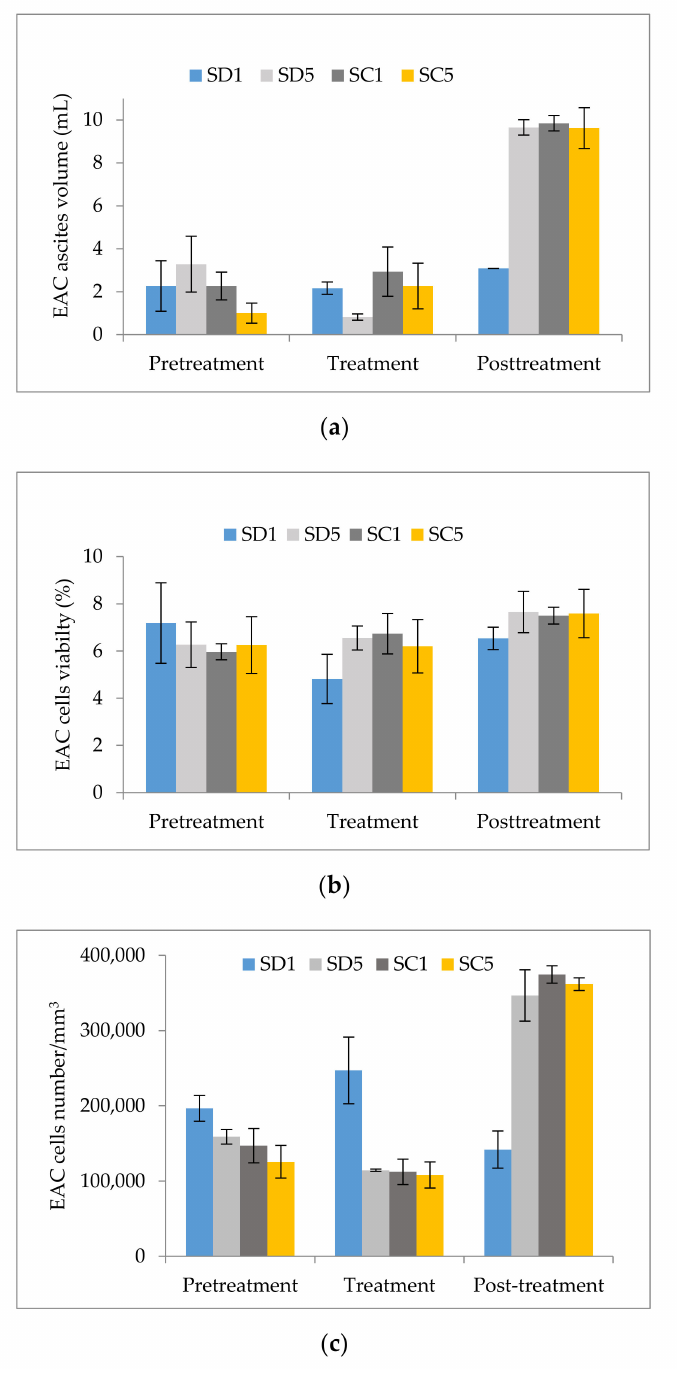
Figure 1. Impact of S. montana extracts on ( a ) Ehrlich ascites carcinoma (EAC) ascites volume, ( b ) EAC cells viability, and ( c ) EAC cells number (SD—spray-dried extract; SC—extract obtained by Sc-CO 2